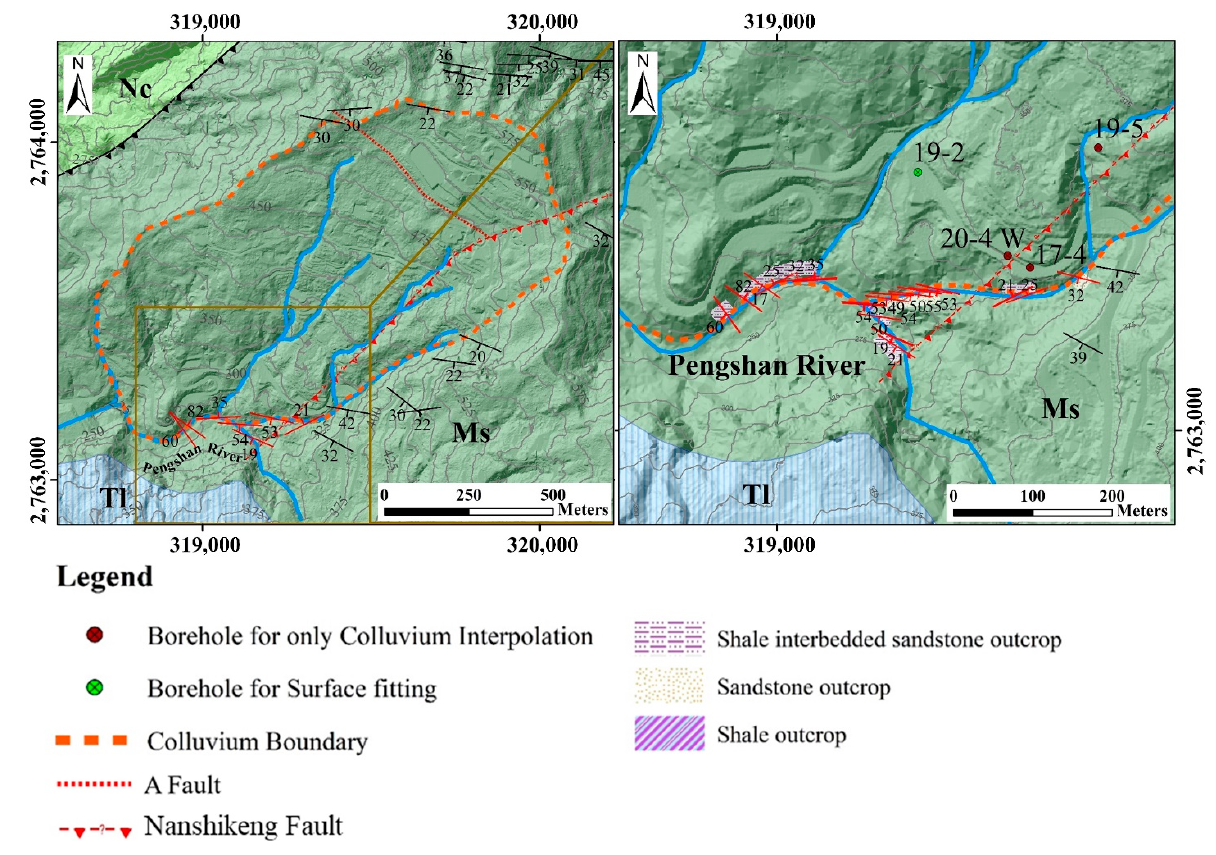
Figure 3. Outcrop measurements along the Pengshan River (red attitudes) compared with the background orientations (black attitudes). The authors measured the attitudes shown in red, whereas the attitudes shown in black were gathered from previous research.